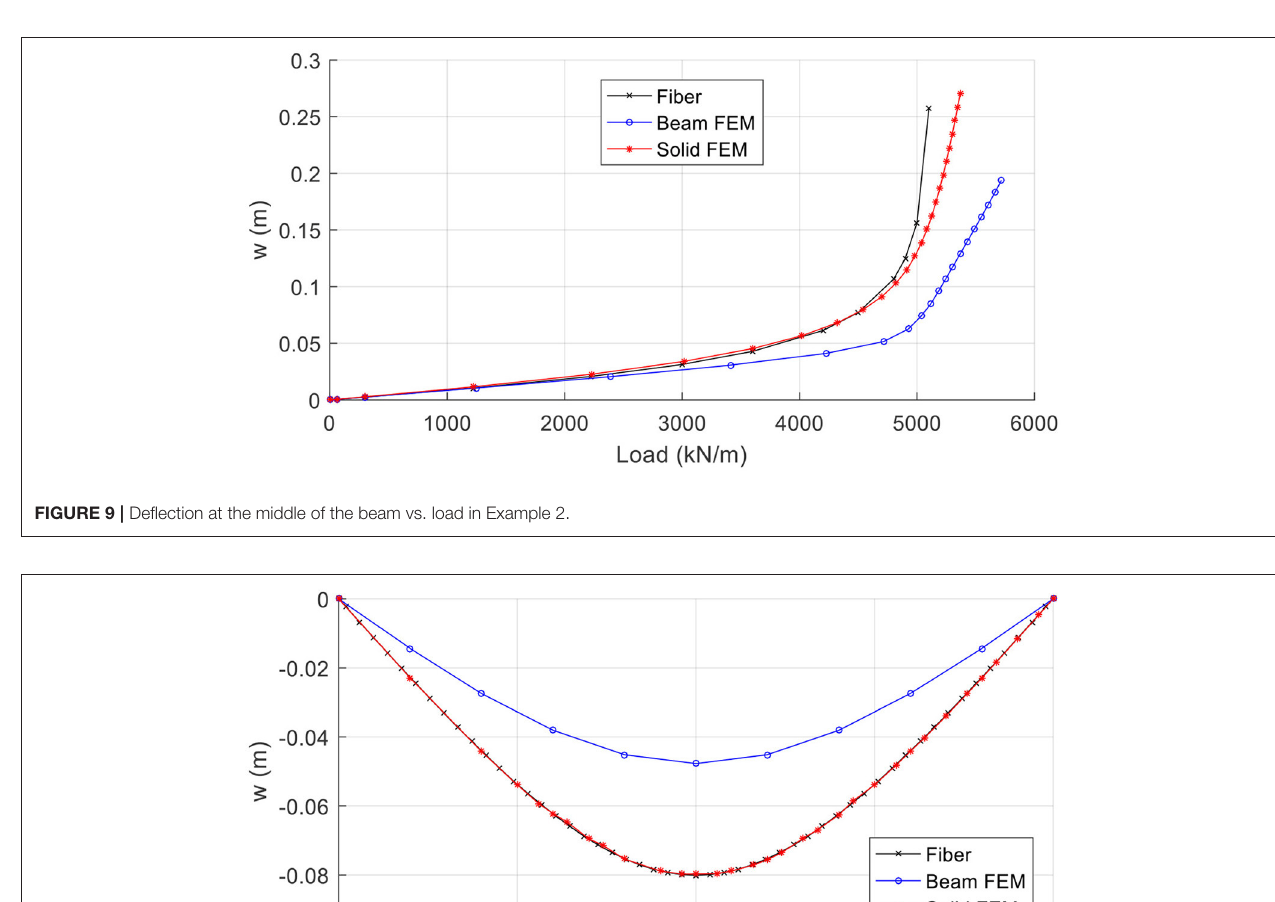
Frontiers in Built Environment | www.frontiersin.org